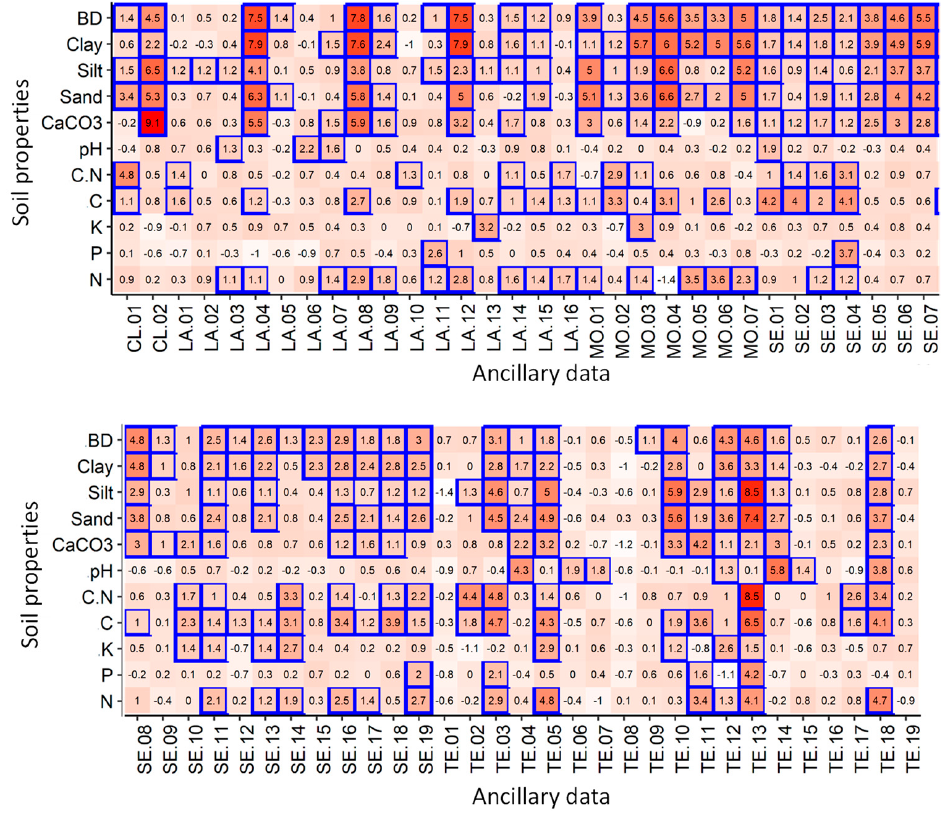
Figure 3. Role of the ancillary data for predicting soil physiochemical properties (darker color indicates the higher importance of ancillary data for each soil property).